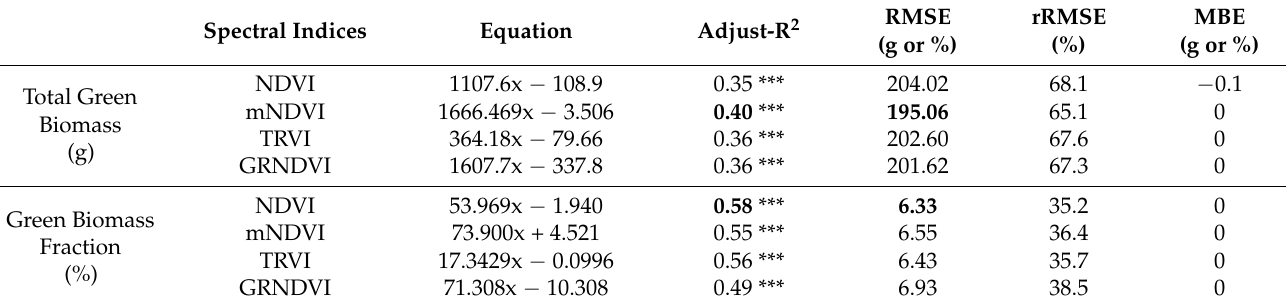
Table 4. Linear regression equations derived by OLS between total GB (y, g) (g) and spectral indices derived from field spectra and (up) and between GBF (y, %) and spectral indices (down). Values in bold shown the best fit index for both estimations. x represents the predictor variable (spectral indices). All regressions were significant (*** p -values < 0.001).